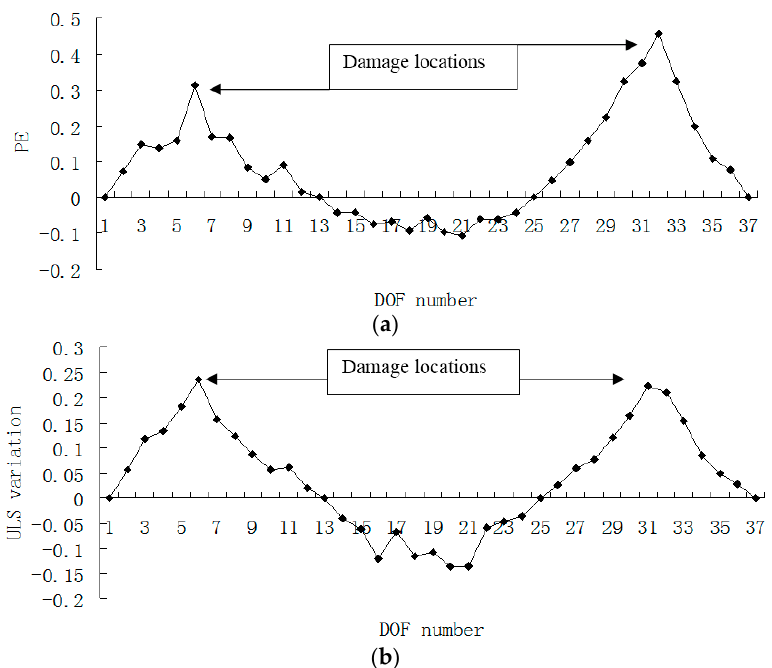
Figure 13. ( a ) Damage index (PE) map using the first four modes with 3% noise when elements 5 and 31 are damaged; ( b ) Damage index (ULS variation) map using the first four modes with 3% noise when elements 5 and 31 are damaged (×10 − 4 ).